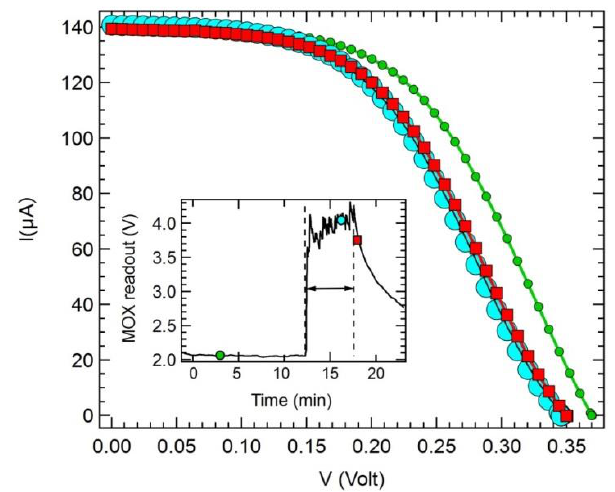
Figure 3. Example of I–V curves collected during different phases of SWCNT/Si PV cell exposure to ammonia in air. Green dots: before exposure, light blue spheres: maximum NH 3 concentration, red squares: early recovery phase. In the inset, these phases are indicated on top of the response curve of the reference metal-oxide-based chemiresistor (MOX) gas sensor collected during exposure. The horizontal arrow denotes the exposure time (approximately 5 min).